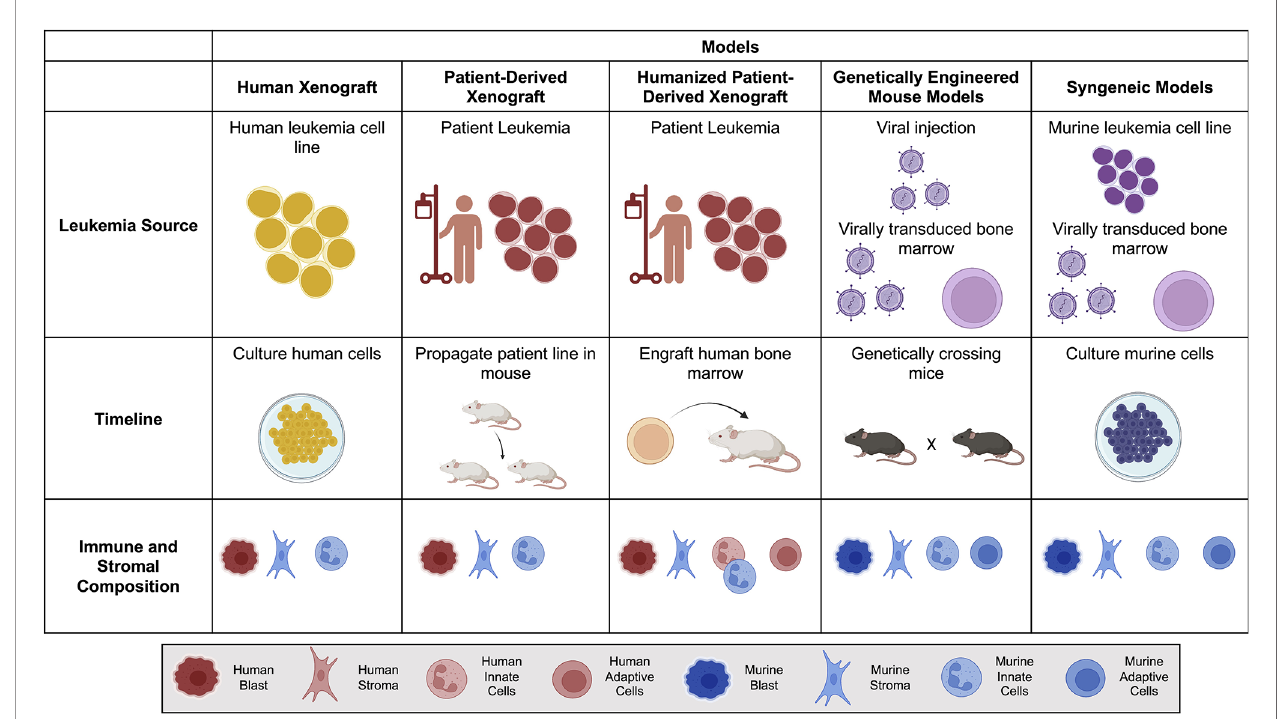
FIGURE 1 | Comparison of mouse models for Adoptive Cell Therapy (ACT). Brief overview of the leukemia source, timeline to propagate and test tumor model, and immune and stromal composition of each mouse model. Human is denoted by warm colors (yellow, orange, red) and murine is denoted by cool colors (blue and purple). Created with